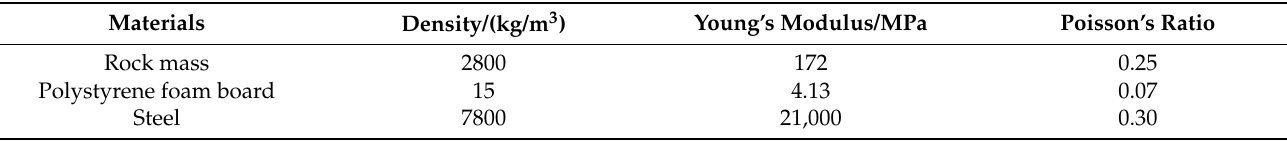
Figure 10. Distribution of damping ratio of the rock mass in frequency domain.